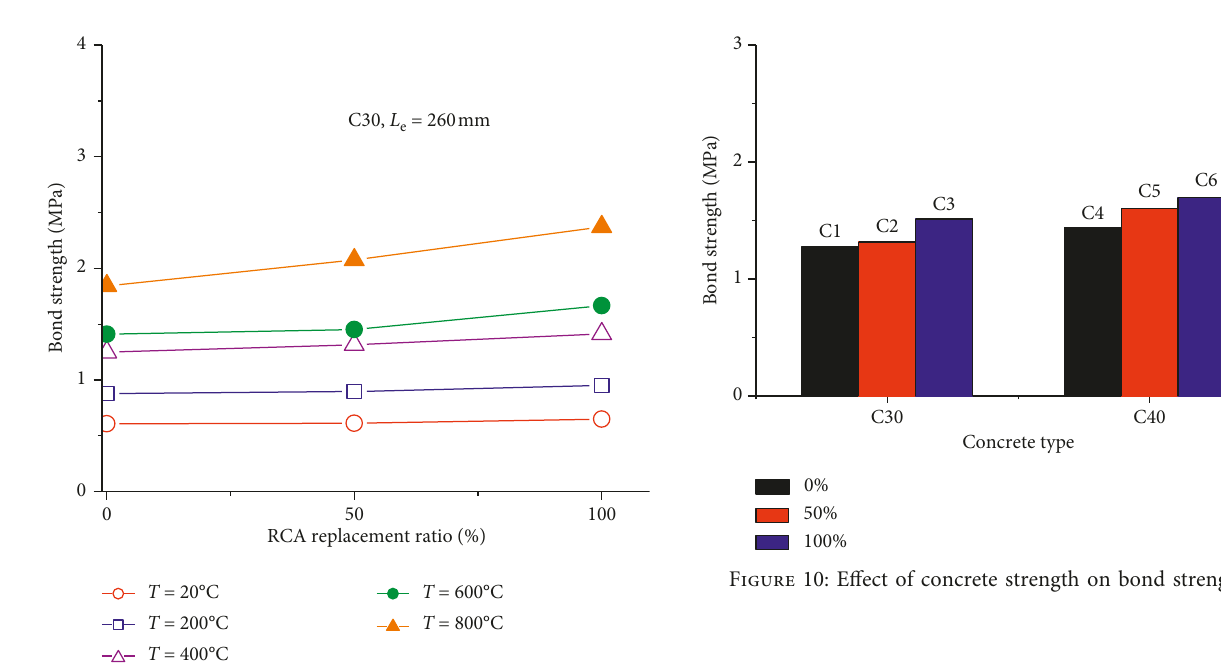
Figure 8: Effect of RCA replacement ratio on bond strength.